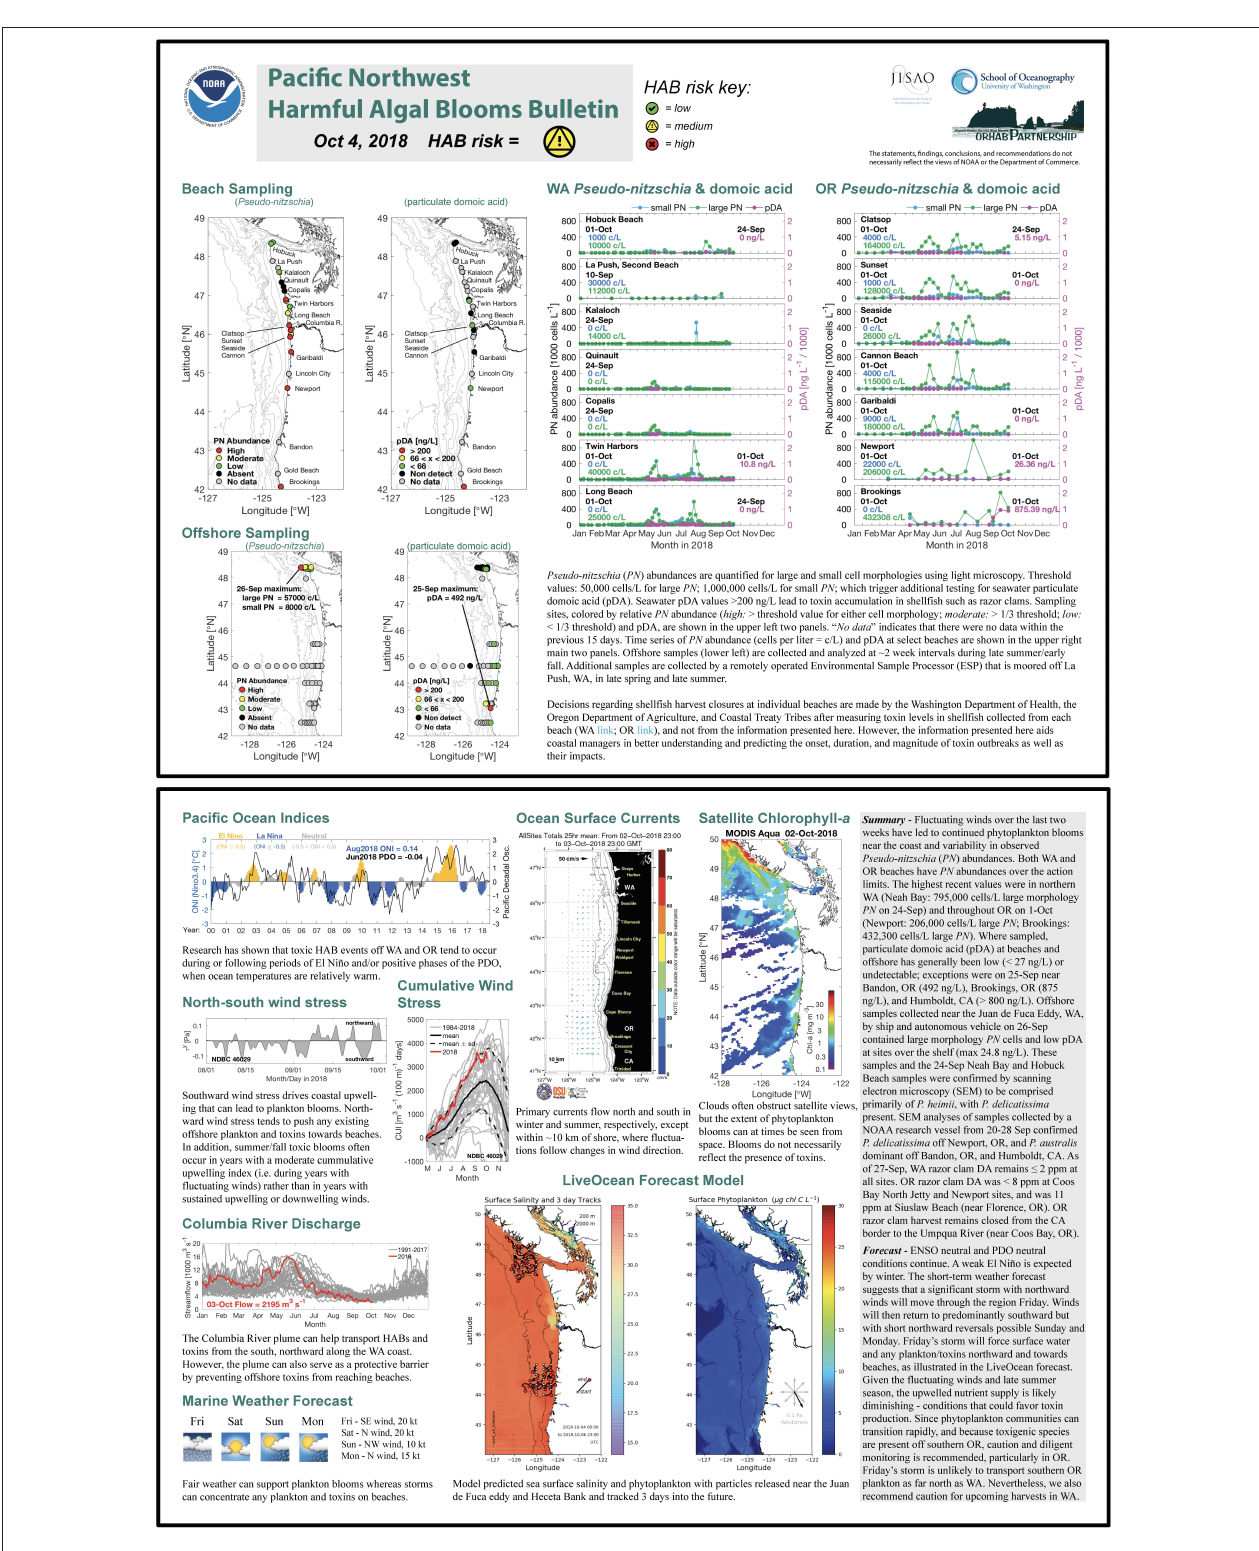
FIGURE 5 | The PNW HAB Bulletin from 4 October 2018 (http://www.nanoos.org/products/habs/forecasts/bulletins/pnw_hab_bulletin-20181004.pdf (accessed 22 Nov 2020)) communicating elevated seawater particulate domoic acid off of Bandon, OR (492 ng/L), Brookings, OR (875 ng/L), and Humboldt, CA ( > 800 ng/L) in late September 2018. Pseudo-nitzschia australis was dominant across those sites at that time.